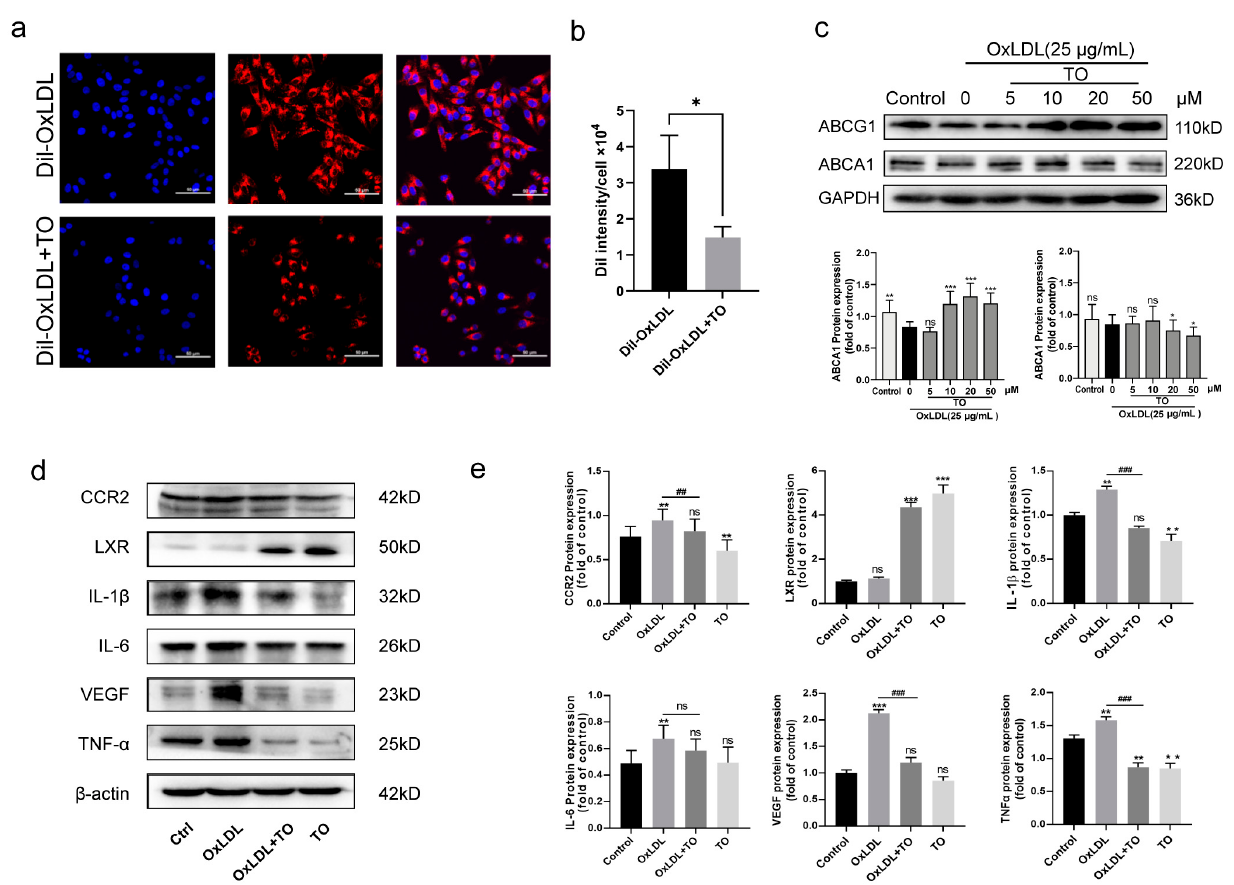
Figure 3. Lipid accumulation and inflammation effect of LXR agonist on OxLDL pretreatment to RPE cell. ( a ) RPE cells were incubated with 25 µ g/mL OxLDL and 10 µ M TO as indicated for 12 h in culture. The phagocytosis of Dil-labeled OxLDL examined by fluorescence staining, Dil-labeled OxLDL (red) and DAPI labeled nuclear (blue), bars = 20 µ m. ( b ) The quantitative results of Dil-OxLDL intensities. Data shown are the mean ± SEM, n = 3, * p < 0.05 vs Dil-OxLDL group. ( c ) To detect and quantify ABCG1 and ABCA1, Western blotting was applied. Values are expressed in terms of means ± SEM, ns indicates p > 0.05, * p < 0.05, ** p < 0.01, *** p < 0.001, * vs. control group ( d ) Western blotting was used to detect the expression of inflammation factors. ( e ) Quantification of inflammation factors expression. Data are expressed as mean ± SEM, n = 3, ns indicates p > 0.05, * p < 0.05, ** p < 0.01, *** p < 0.001 vs. control group, ## p < 0.01, ### p < 0.001 vs. OxLDL